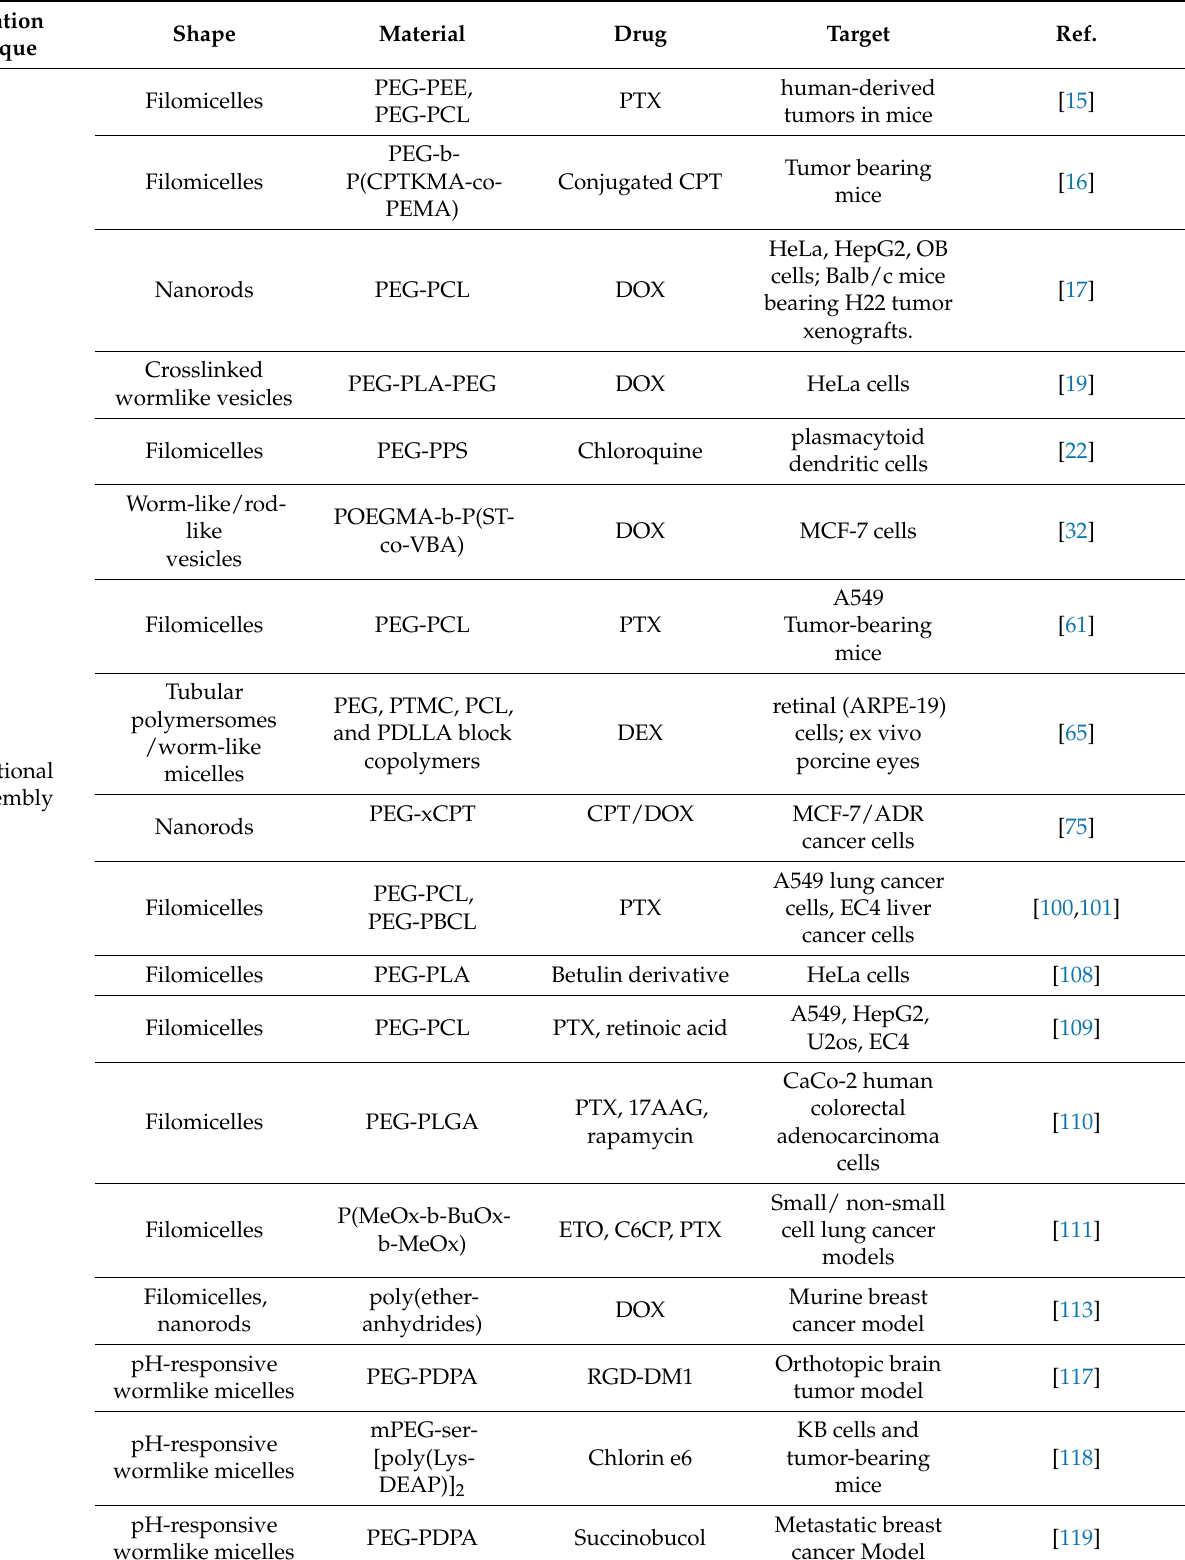
Table 3. Non-spherical nanocarriers for drug delivery